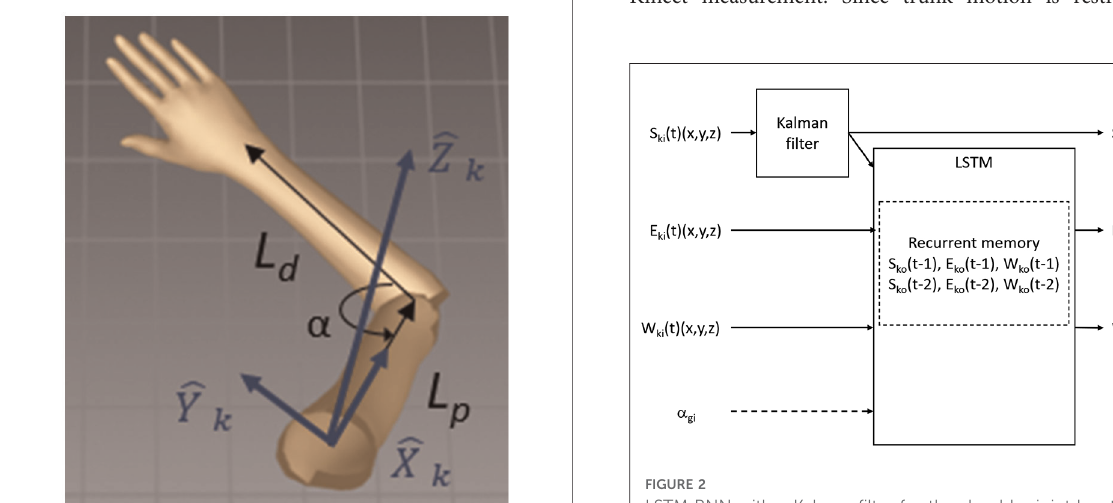
FIGURE 2 LSTM RNN with a Kalman fi lter for the shoulder joint location. The network receives measurements from the sensors and has a recurrent memory of two previous time steps. S: shoulder, E: elbow, W: wrist, α : elbow angle, k: Kinect frame, g: goniometer, α is the elbow i: input, o: output, t: time. One network included the goniometer measurement as input, and the other did